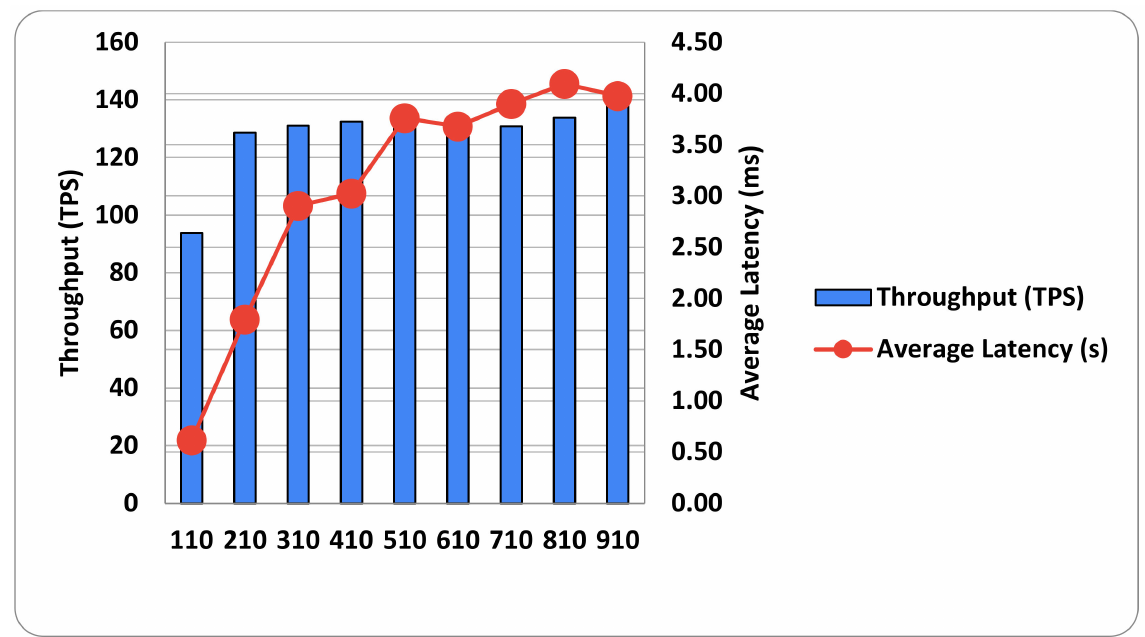
Figure 8. Various send rates for read latency and read throughput.